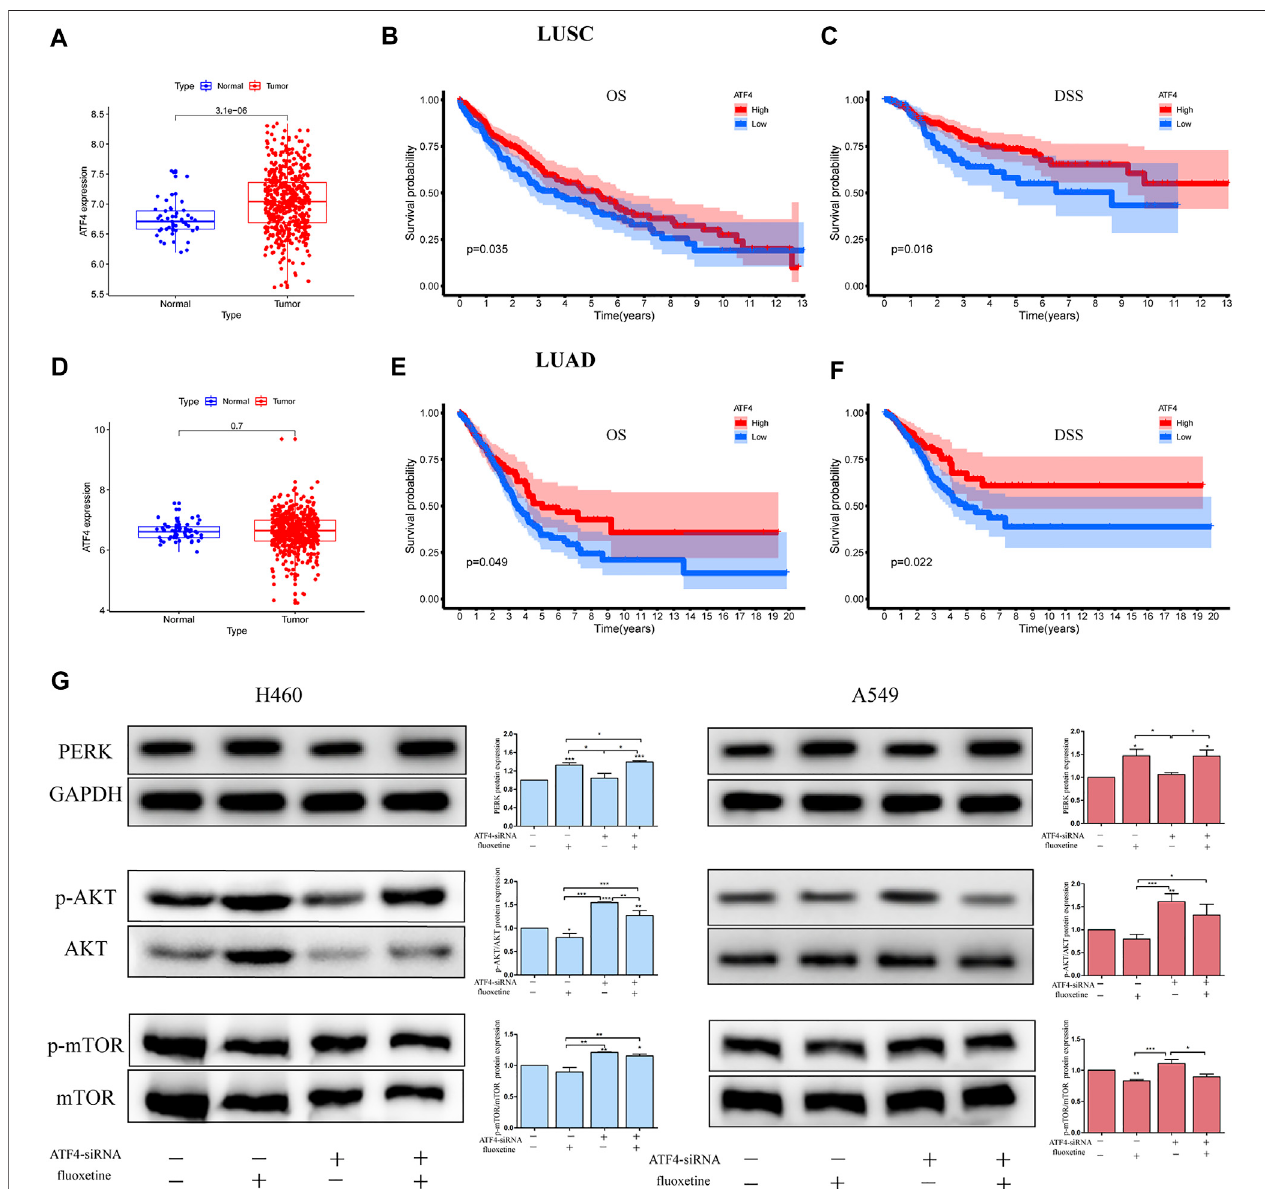
FIGURE 6 | AKT/mTOR signaling pathway was regulated through ATF4 in fl uoxetine treatment. (A,D) Expression of ATF4 in normal and tumor tissues was detected in the TCGA database. The blue spots on the left were the normal group, and the red spots on the right were the tumor group. [ (B,C) , (E,F) ] Survival analysis comparinghightolowexpressionofATF4inlungcancer. (G) ExpressionofPERK,p-AKT/AKTandp-mTOR/mTOR inlungcancercellstransfectedwithATF4siRNAfor 48 h followed by exposure to fl uoxetine (20 μ M) for another 24 h was tested by Western blot. The images were collected from different parts of the same gel. Data are presented as mean ± SD; * p < 0.05, ** p < 0.01, *** p < 0.001.